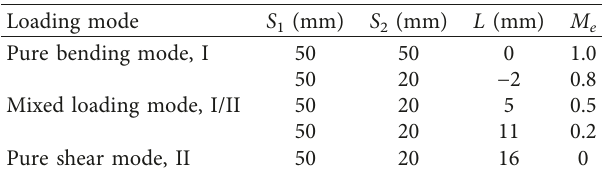
Table 2: Positions of bearings and prefabricated crack at different loading